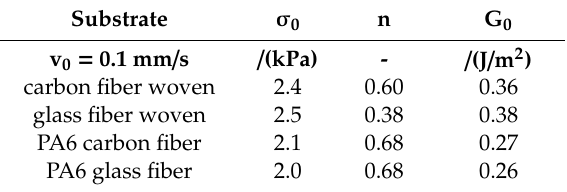
Figure 7. Measured tractive stresses σ t between the PDMS-soft gripper stamp and the investigated substrates at various pulling speeds (points) with the fit function (Equation (7)) as dashed lines. Table 2. Fit parameter of the tractive stress and the corresponding calculated G 0 .